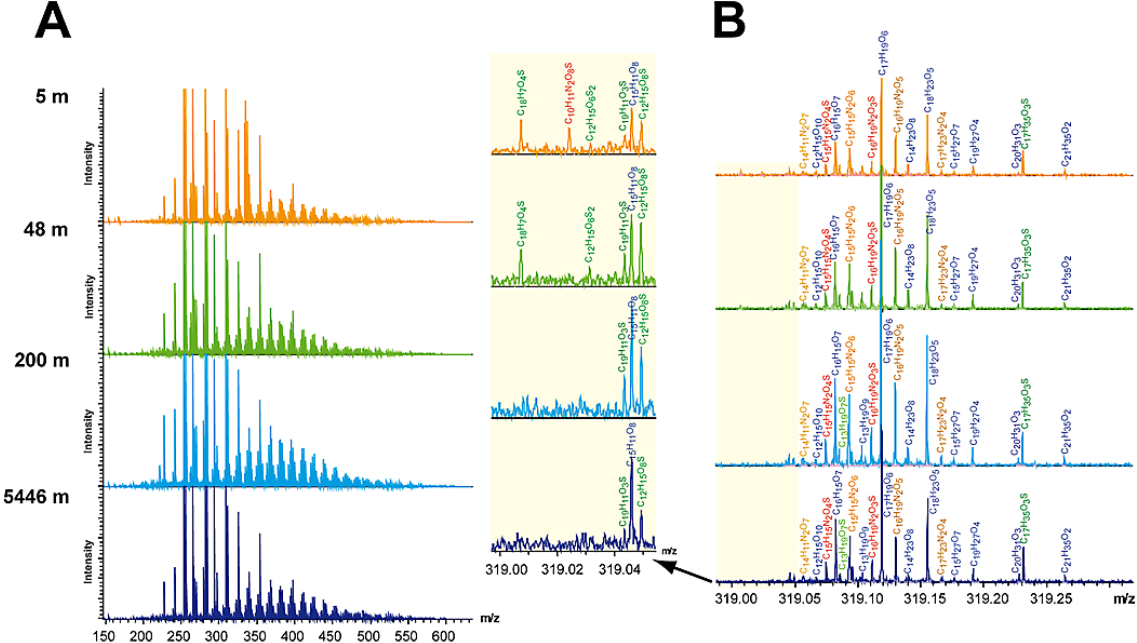
Fig. 14. Negative electrospray 12TFTICR mass spectra of marine SPE-DOM; from top to bottom: 5m (near-surface photic zone); 48m (fluorescence maximum); 200m (upper mesopelagic zone); 5446m (30m above seafloor). (A) FTICR mass spectra from 150–650Da; (B) expansion of nominal mass 319 for negative ions MH − with molecular formulae provided on the basis of their mass accuracy and mass resolution (cf. text). Insert (B) expansion of the mass segment 319–319.05Da ( 1m = 0 . 05Da) with enhanced relative intensity, indicating mostly CHOS molecules which discriminate between top and bottom marine